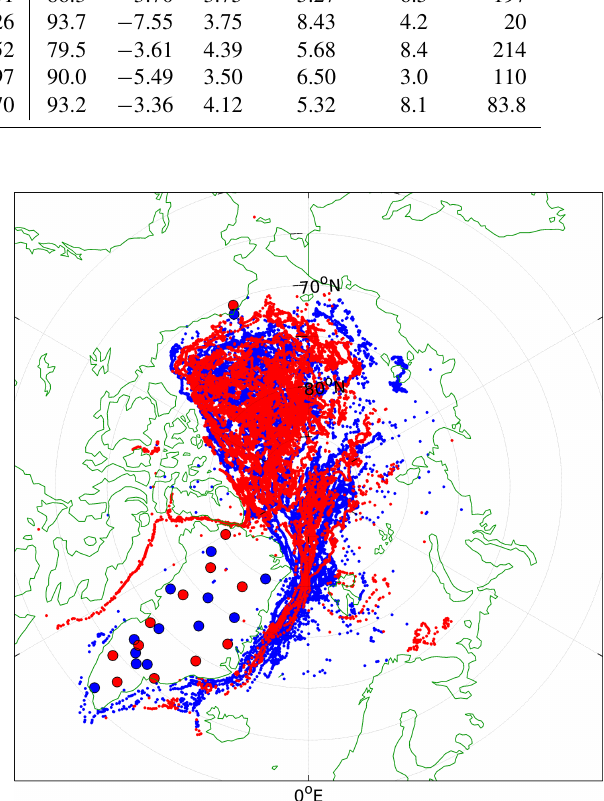
Figure 5. Positions of matchups on sea ice and land ice (red: train- ing; blue: